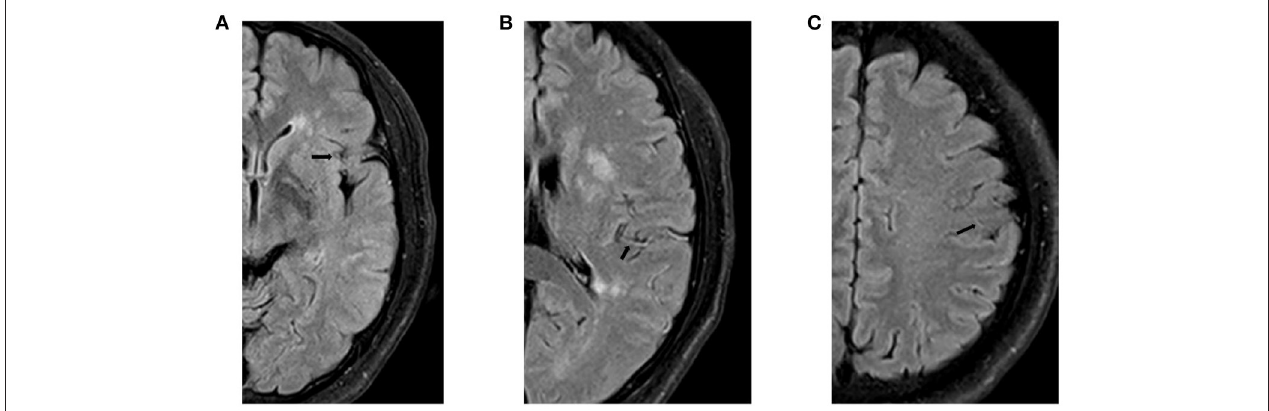
FIGURE 3 | Hyperintense vessel sign (HVS): (A) Score of 1, restricted to Sylvian fissure; (B) Score of 2, limited to Sylvian fissure and cerebral sulci of temporo-occipital junction; and (C) Score of 3, extension to cerebral sulci of frontoparietal lobe, in addition to locations scored as 1 or 2.